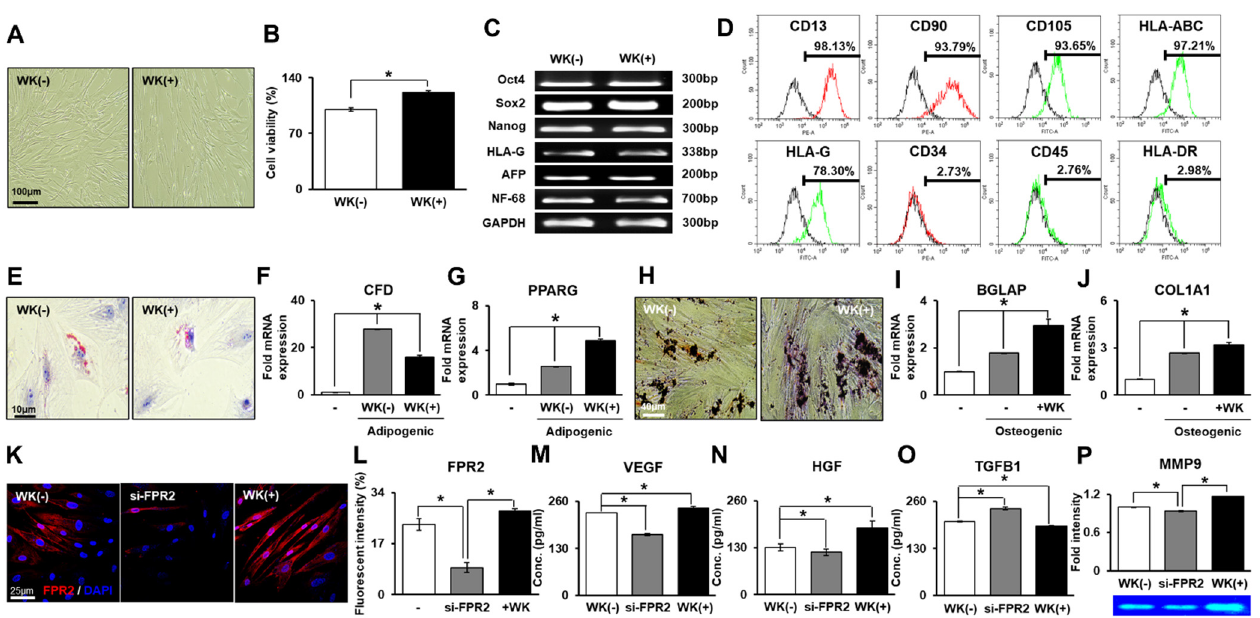
Figure 1. WKYMVm treatment maintains and enhances PD-MSC characteristics and effects. ( A ) Morphology of the PD-MSCs and WKYMVm-treated PD-MSCs. Scale bar = 100 μ m. ( B ) Viability of the PD-MSCs and WKYMVm-treated PD-MSCs shown by CCK-8 assays. ( C ) Expression of stemness-related markers in the WKYMVm-treated PD-MSCs shown by RT-PCR. ( D ) MSC surface markers (e.g., hematopoietic, nonhematopoietic, and HLA family) in the WKYMVm-treated PD-MSCs using FACS analysis. ( E ) Lipid droplets in PD-MSCs differentiated into adipocytes shown by Oil Red O staining. Scale bar = 10 μ m. Expression of adipogenic-specific markers such as CFD ( F ) and PPARG ( G ) shown by qRT-PCR. ( H ) Calcium deposition of PD-MSCs differentiated into osteocytes shown by von Kossa staining. Scale bar = 40 μ m. Expression of osteogenic-specific markers, including BGLAP ( I ) and COL1A1 ( J ), shown through qRT-PCR. ( K ) Expression of FPR2 in PD-MSCs using immunofluorescence. Scale bar = 25 μ m. ( L ) Quantification of the fluorescence intensity of FPR2 through immunofluorescence. Expression of VEGF ( M ), HGF ( N ), and TGFB1 ( O ) in the WKYMVm-treated PD-MSC culture supernatants shown by ELISAs. ( P ) The activity of MMP9 in the WKYMVm-treated PD-MSC culture supernatant shown using gelatin zymography. Mean ± SD, * p < 0 .05 by t tests. si-FPR2, siRNA-FPR2-transfected PD-MSCs; +WK, WKYMVm-treated